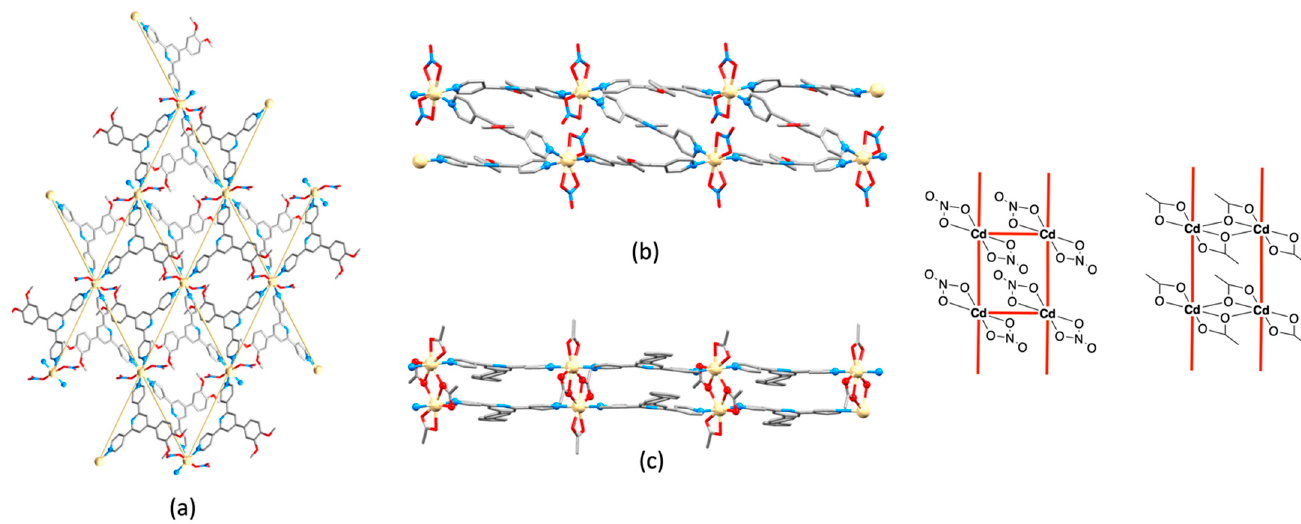
Figure 30. ( a ) Part of one (4,4) net in [Cd( 48 ) 2 (NO 3 ) 2 ] n (CSD refcode COGWEC); each Cd atom is a 4-connecting node and the rhombuses in the net are highlighted. Part of the 1D-ladder ( b ) in [Cd 2 ( 49 ) 3 (NO 3 ) 4 ] n · n MeOH . n CHCl 3 (CSD refcode BUDZIL), and ( c ) [Cd 2 (OAc) 4 ( 30 ) 2 ] n · 1.75 n MeOH · 0.5 n H 2 O (CSD refcode RIGJEY). Right: a schematic representation of the different ladder assemblies.